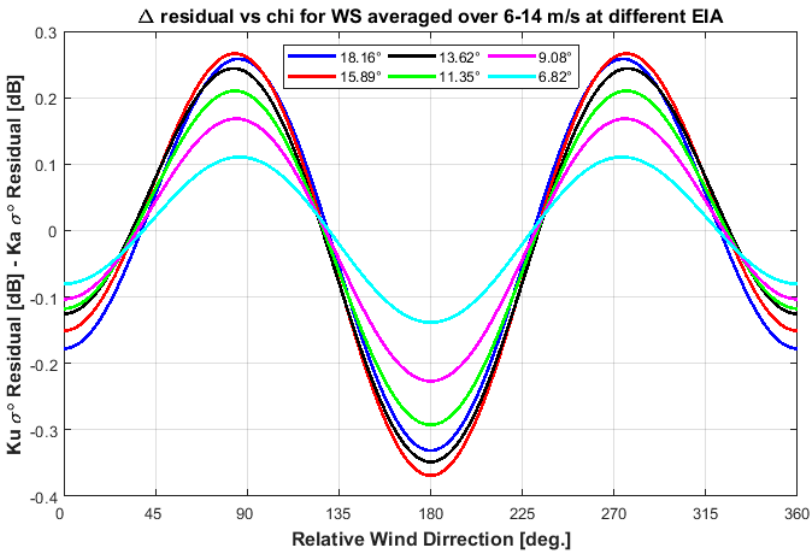
Figure 15. Delta residual (in dB) between KuPR and KaPR σ 0 directional anisotropy as a function of relative wind direction ( χ ) at different EIAs, for wind speed averaged over 6 – 14 m/s.